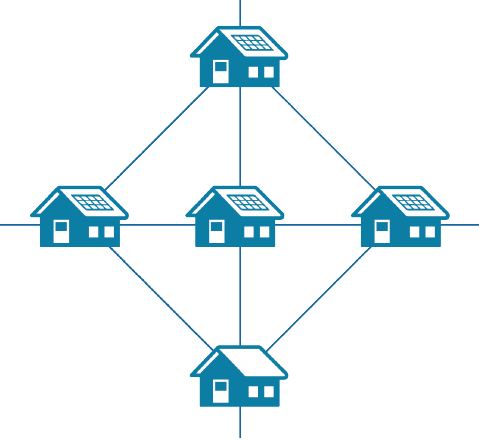
Figure 2. Concept illustration of an interconnected SHS-based meshed DC